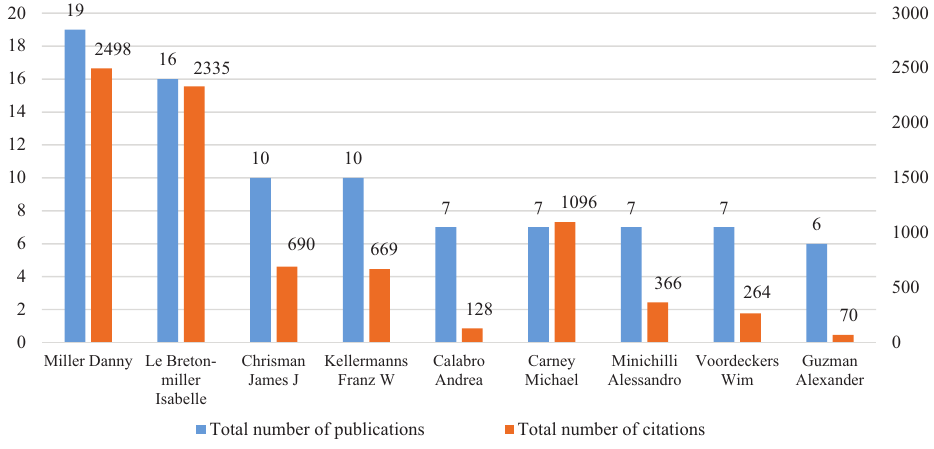
Figure 7. The most productive and cited